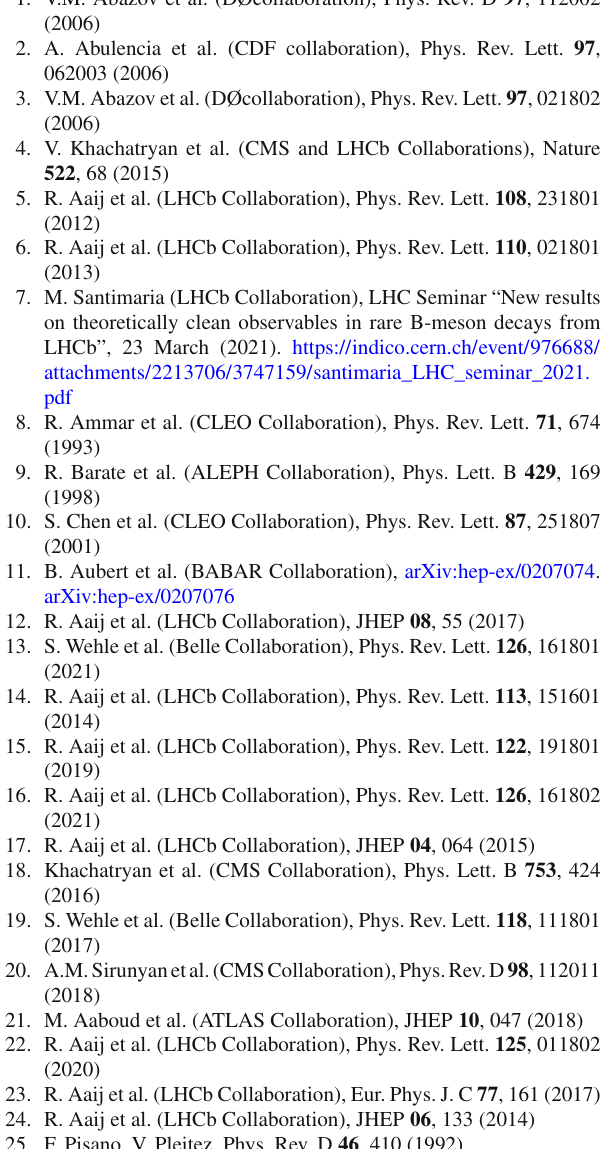
Fig. 7 The figure presents the comparison of the dependence of the total branching ratio Br (μ → e γ) total on the NP scale w with u = 5 GeV, u = 10 GeV and u = 20 GeV, respectively. The solid black line indicates the upper bound from the experiment